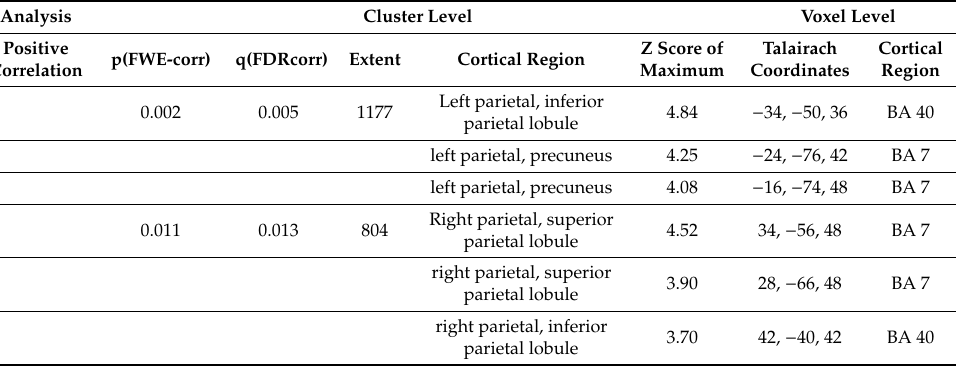
Table 4. A general overview of statistical parametric mapping analyses that detected a positive correlation in left and right Brodmann area (BA) 7 and left and right Brodmann area 40 of FDG uptake and performance in RCFT, copy test. The Brodmann areas were then identified at a range of 0 to 3 mm from the corrected Talairach coordinates of the SPM output isocentres. A statistical height threshold was equal to or lower than p < 0.001 at both clusters, and voxel-level was accepted as significant. We considered as significant a cluster extension of more than 125 contiguous